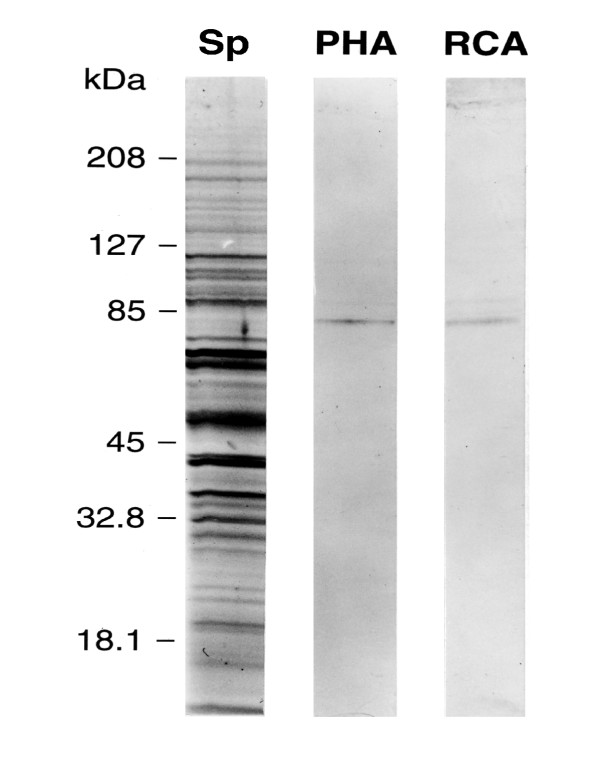
Lectin labelling of solubilized barbel epithelial proteins SDS-PAGE (4–20%) of 10 μg of solubilized barbel homogenate stained with silver (Lane "Sp") or probed with PHA-E lectin (Lane "PHA") or RCA-I lectin (Lane "RCA") using lectins at 10 μg/ml with ABC detection. Both lectins label a band at 82 – 84 kDa and lightly label at least two other bands, one near 88 kDa, the other near 120 kDa.